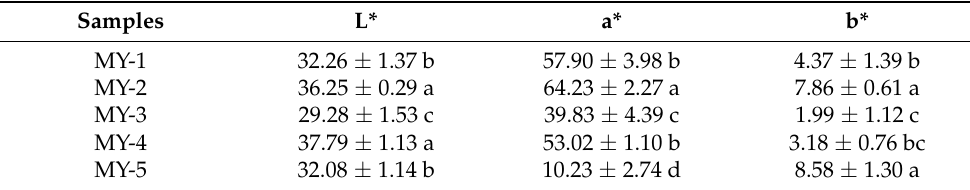
Table 1. Chromatic aberration values of different tissues of R. delavayi .